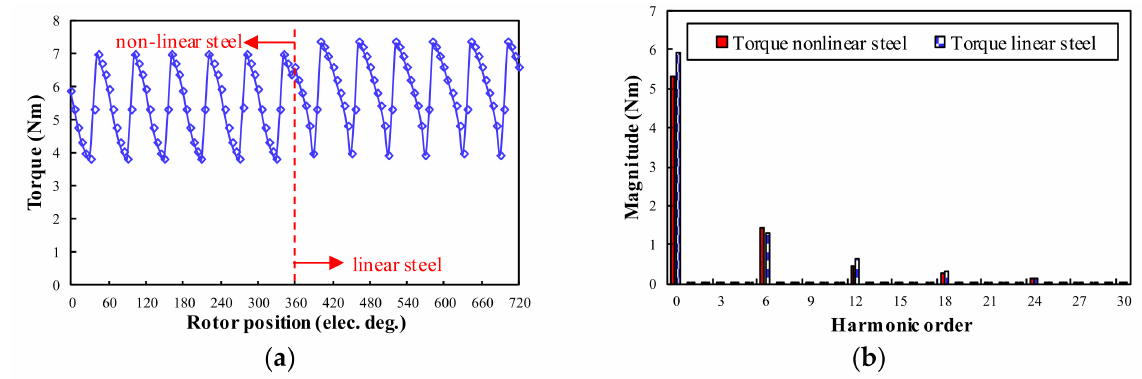
Figure 10. On-load torque waveforms and spectra for 24/4 WRSM: ( a ) Waveforms; ( b )